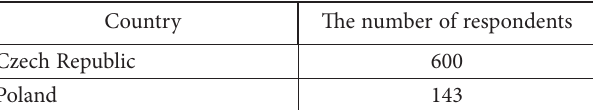
Country The number of respondents Czech Republic 600 Poland